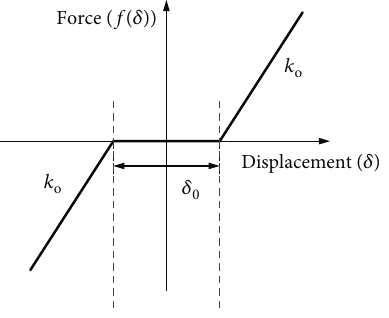
Figure 3: Restoring force of freeplay